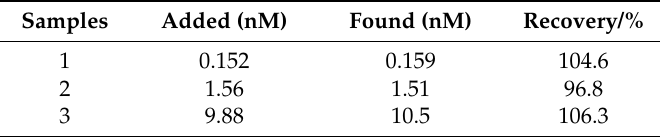
Table 2. The recovery of myoglobin from human serum samples.